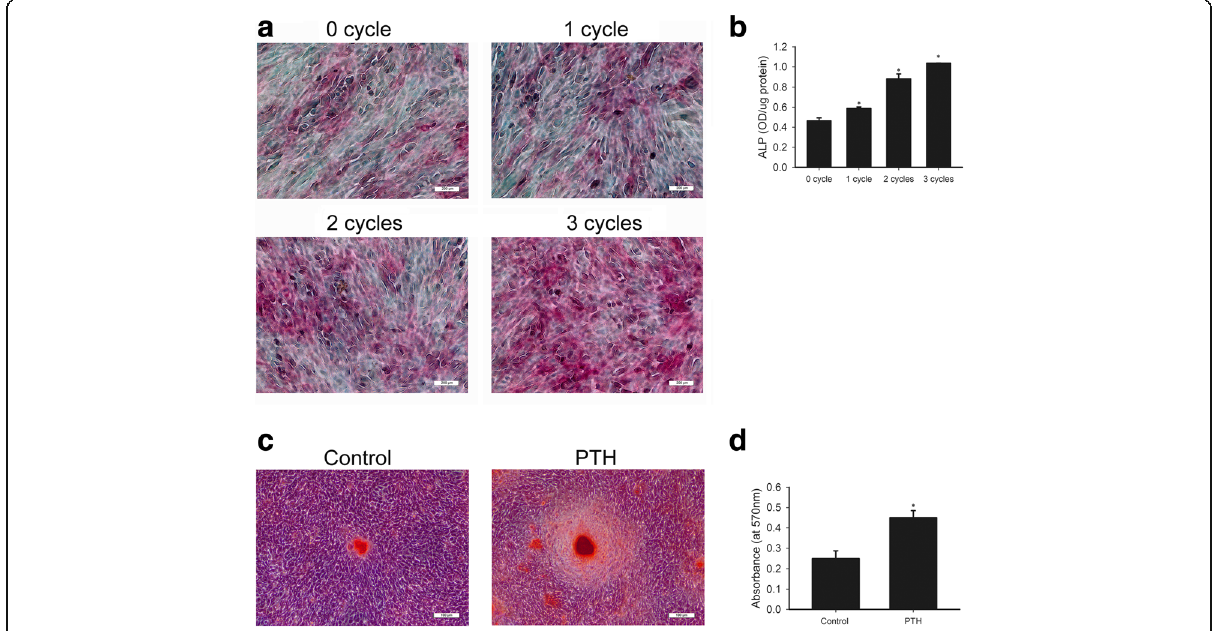
Fig. 3 Intermittent PTH administration enhanced ALP activity and the formation of mineralized nodules. a Representative images of ALP staining of OCCM-30 cells after treatment with vehicle, 1 cycle, 2 cycles and 3 cycles of intermittent PTH. They together demonstrated a progressively enhanced ALP + staining consistent with the increasing numbers of administration cycles. Scale bar: 200 μ m. b ALP assay of 0, 1, 2 and 3 cycles of intermittent PTH treated groups. * indicates significant difference between 0 cycle group and other three groups ( p < 0.05). c Microscopic findings of the Alizarin red S staining of the control group and the PTH group. The area of observable mineralized nodules in intermittent PTH treated group was obviously larger in comparison with that of the control group. Scale bar: 100 μ m. d Alizarin red S extraction assay from the control group and the intermittent PTH treated group. * p <